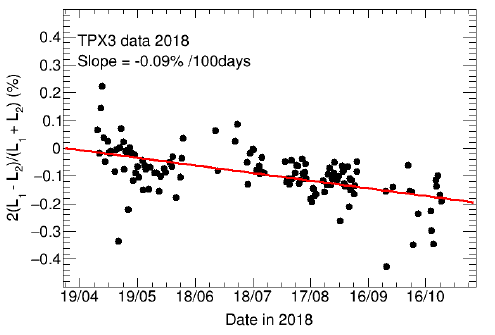
Figure 68. Relative difference between the luminosities measured by layers 1 and 2 of the TPX3 device as a function of time, using cluster-counting. The 2018 TPX3 data are grouped into LHC fill time periods. The size of the statistical error bar is below the size of the data point. A linear fit is applied to determine the slope. LHC fills from April to October 2018. Taken from Ref.